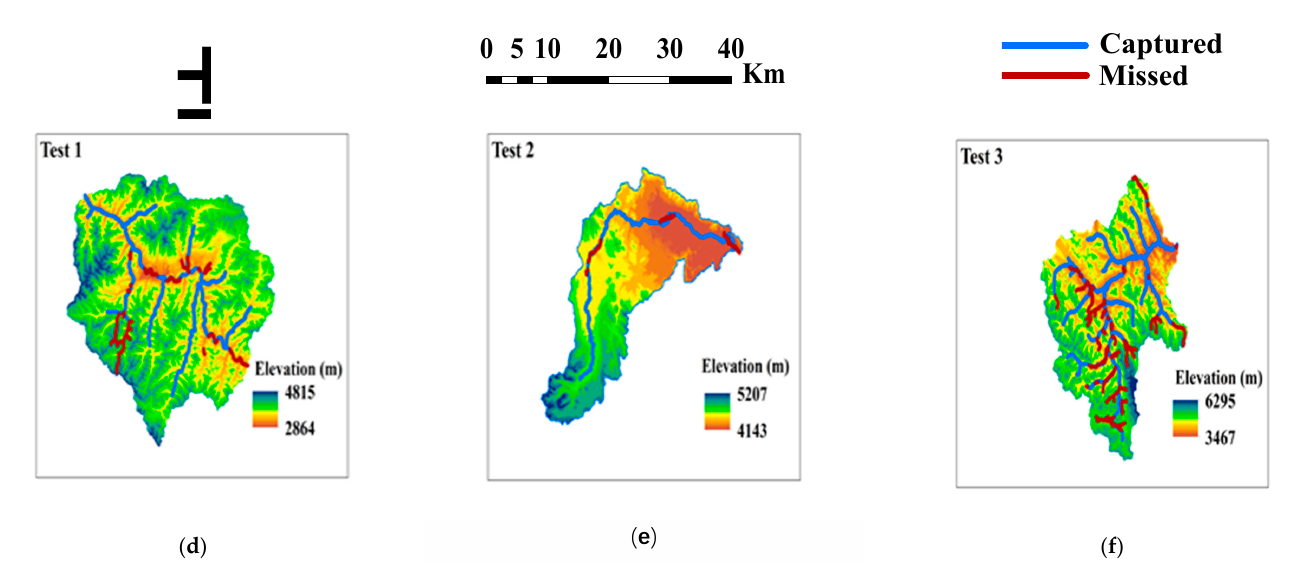
Figure 4. Maps of selected river networks in Qinghai Province. ( a ). Scaling equation for test area 1. ( b ). Scaling equation for test area 2. ( c ). Scaling equation for test area 3. ( d ). Map of captured and missed streams in test area 1. ( e ). Map of captured and missed streams in test area 2. ( f ). Map of captured and missed streams in test area